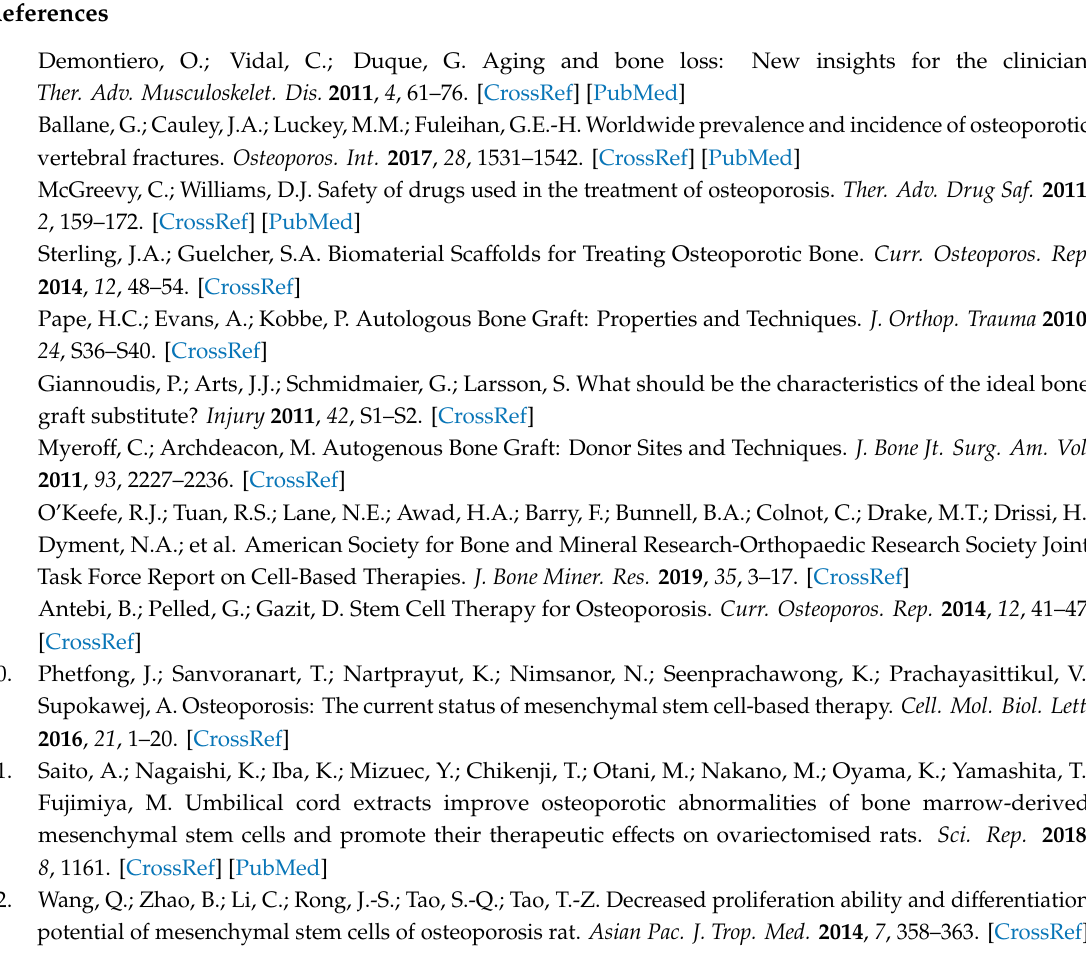
Figure S1: Long-term cultivation of ASCs in 3D aNFC does not a ff ect their